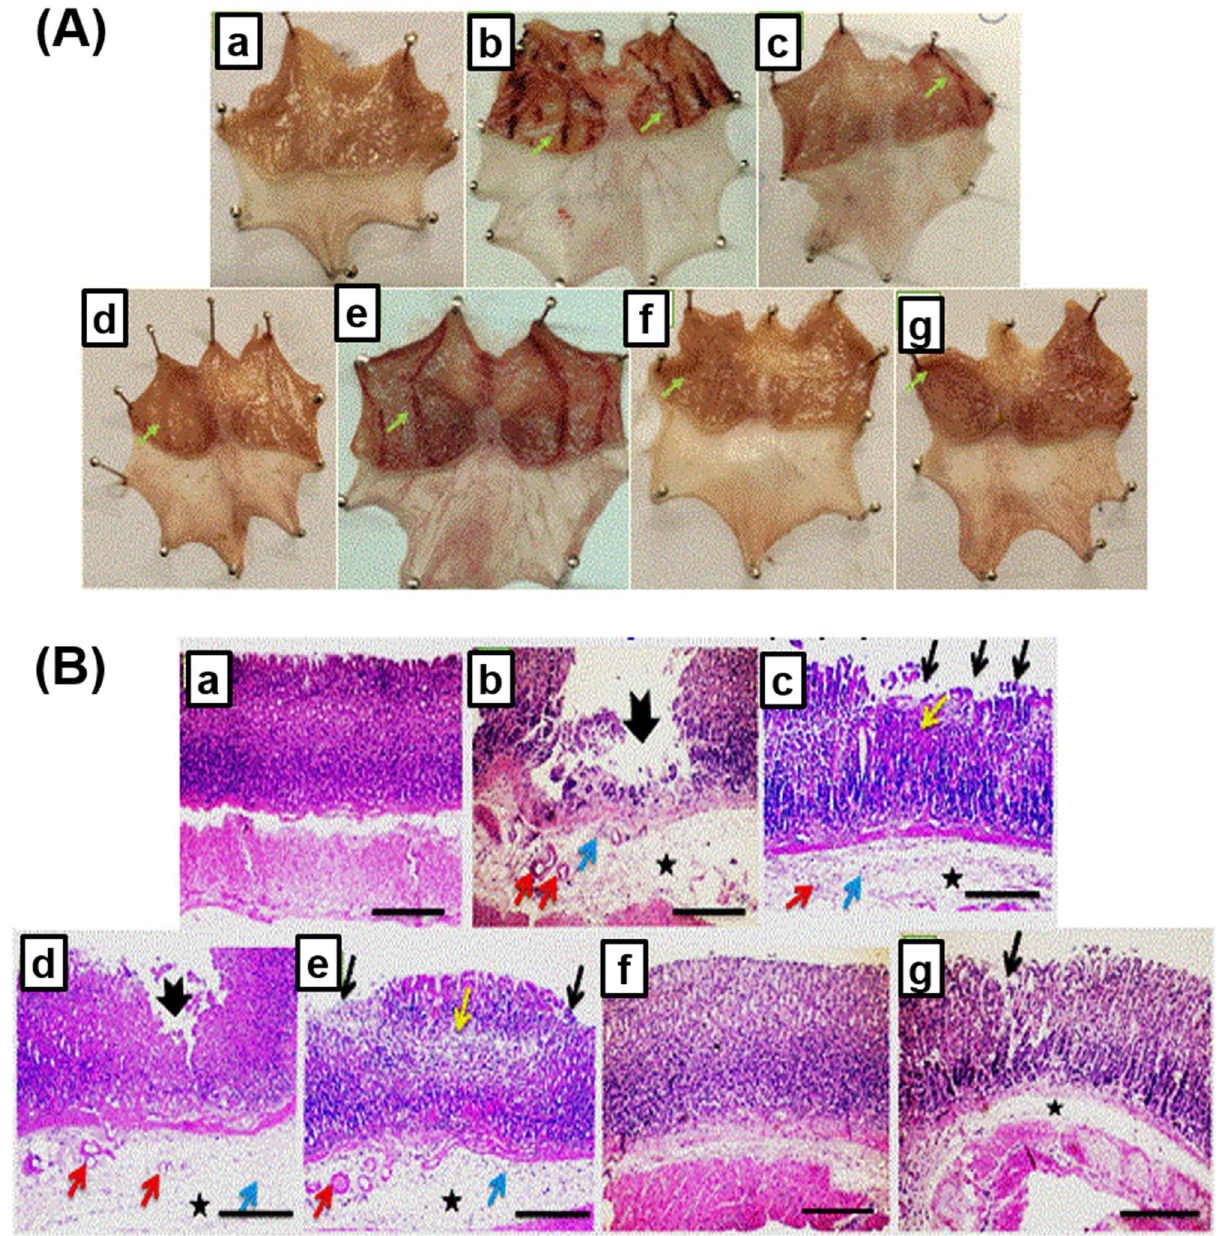
Figure 9. ( A ) Macroscopically investigation of mucosal lesions in glandular part of the stomachs. (a) N group, (b) ulcer group, (c) ome group, (d) plain group, (e) ALL group, (f) NanoAL group, and (g) NanoAH group. ( B ) Microscopical examination of glandular part of stomach sections stained by (H&E) (X: 100). (a) N group, (b) ulcer group, (c) ome group, (d) plain group, (e) ALL group, (f) NanoAL group, and (g) NanoAH group. Green arrow points to visual changes than the normal mucosa present in N group, thick black arrow points to mucosal ulceration, thin black arrow points to erosion, yellow arrow points to necrosis, asterisk points to edema, red arrow points to dilated blood vessel, and blue arrow points to leukocytic cells